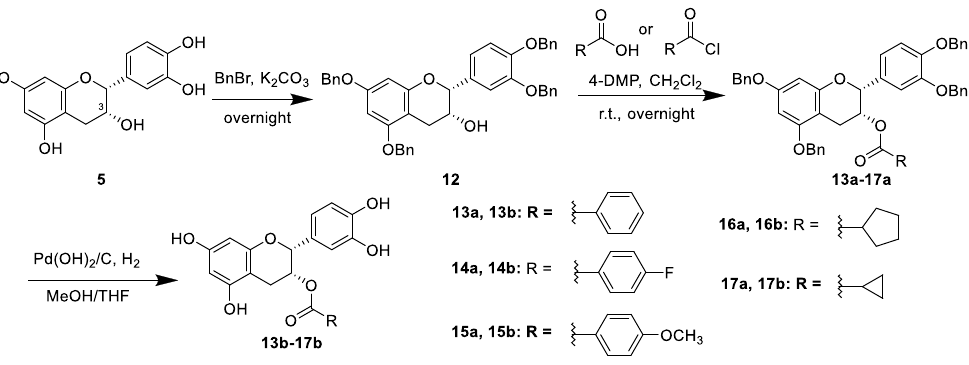
Scheme 1. Synthesis of ECG congeners.